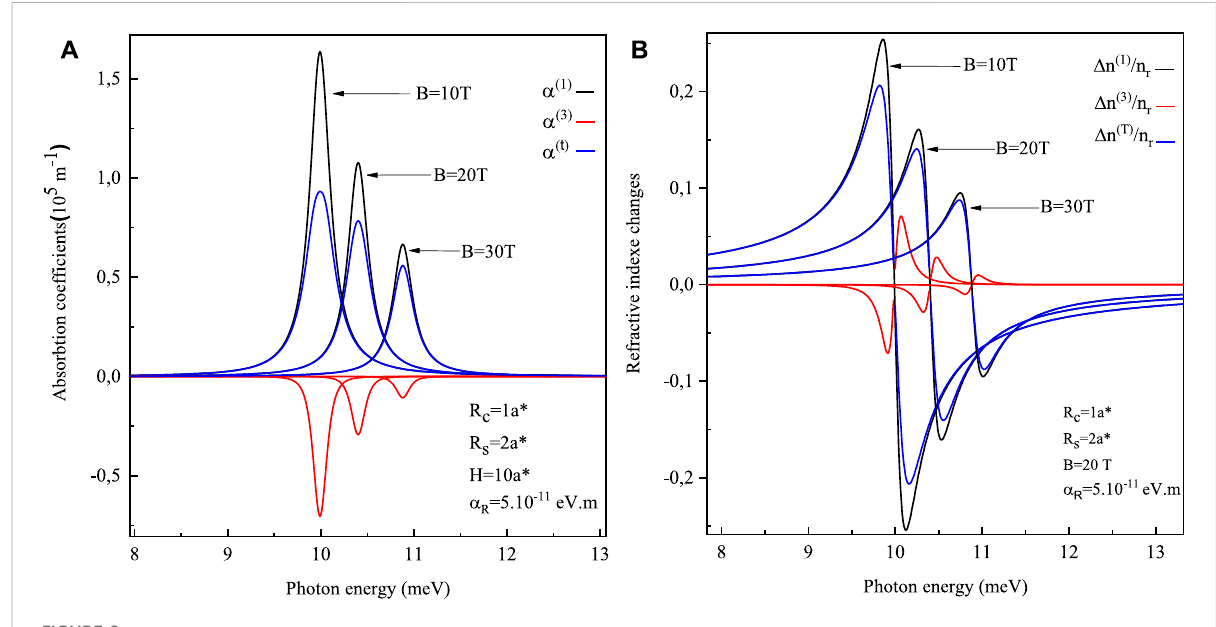
FIGURE 8 Thelinear,thirdordernonlinearandthetotalabsorptioncoef fi cients (A) andrefractiveindexchanges (B) asfunctionsofincidentphotonenergy with different values of magnetic fi eld B = 10, 20, and 30 T and SOI strength α R = 5 × 10 − 11 eV m , R c = 1 a *, R s = 2 a *, H = 10 a *.